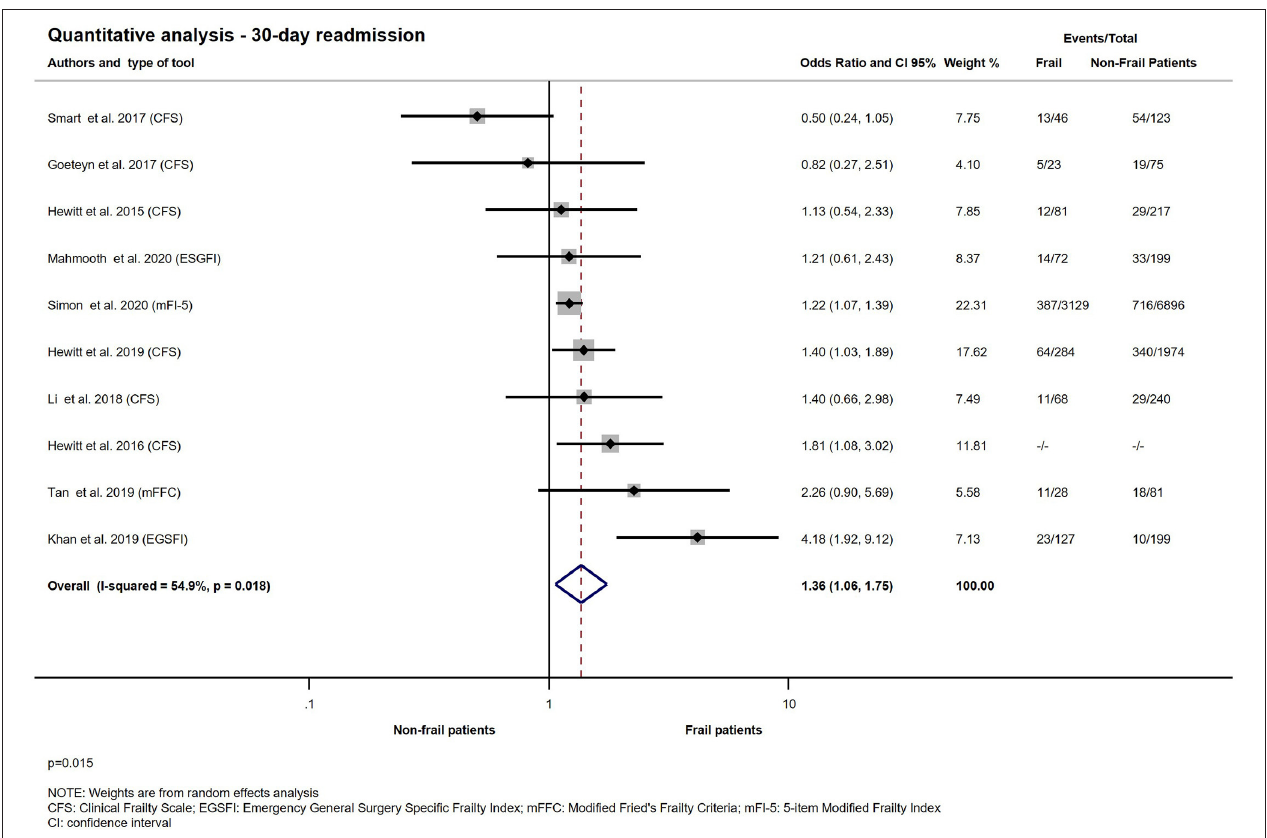
FIGURE 9 | Quantitative analysis − 30-day readmission for emergency surgical patients living with frailty compared to non-frail patients. For patients living with frailty, the overall OR of 30-day readmission was 1.36 (1.06–1.75) From the study of Hewitt et al. (23) a crude OR was pooled with the ORs calculated from raw data. Note moderate